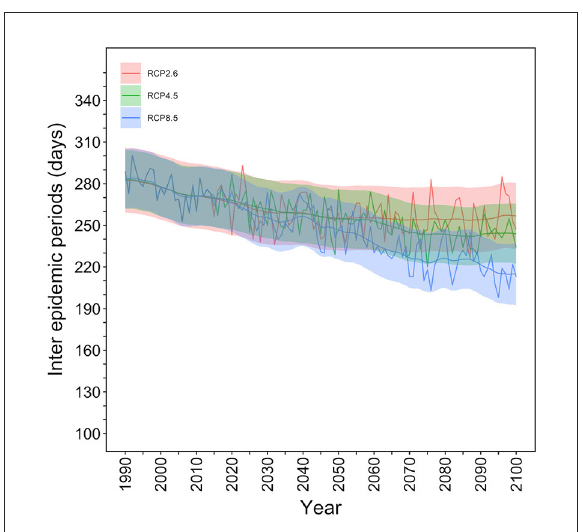
FIGURE4 Interepidemic periods in Tokyo for each RCP scenario. The number of days in a year when the extinction probability is 100% were counted and defined as the interepidemic period (IEP). The temporal distribution of the IEP for the selected mesh, which contains Yoyogi Park in Tokyo, is shown. The thick line shows the expected IEP values, and the upper and lower shaded areas are 95% confidence intervals (CIs), including the observation error calculated using Kalman filtering and smoothing. In 1990, IEP values were 280 (95% CI: 260–302) days per year, but this decreased by ∼ 2 months to 220 days (95% CI: 190–240) under RCP8.5 scenario in the year